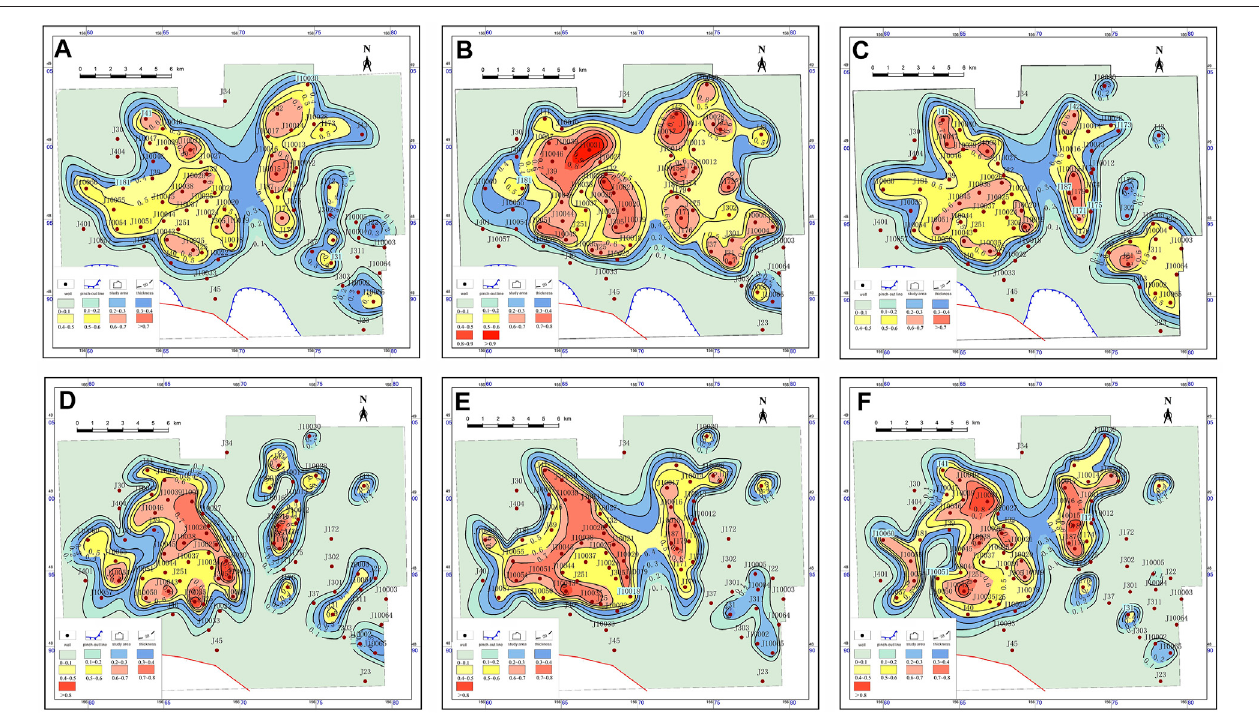
FIGURE 11 | NM saturation distribution diagram of sweet spots in the Lucaogou Formation of the Jimsar Sag. (A) NM saturation distribution diagram of sweet spots in